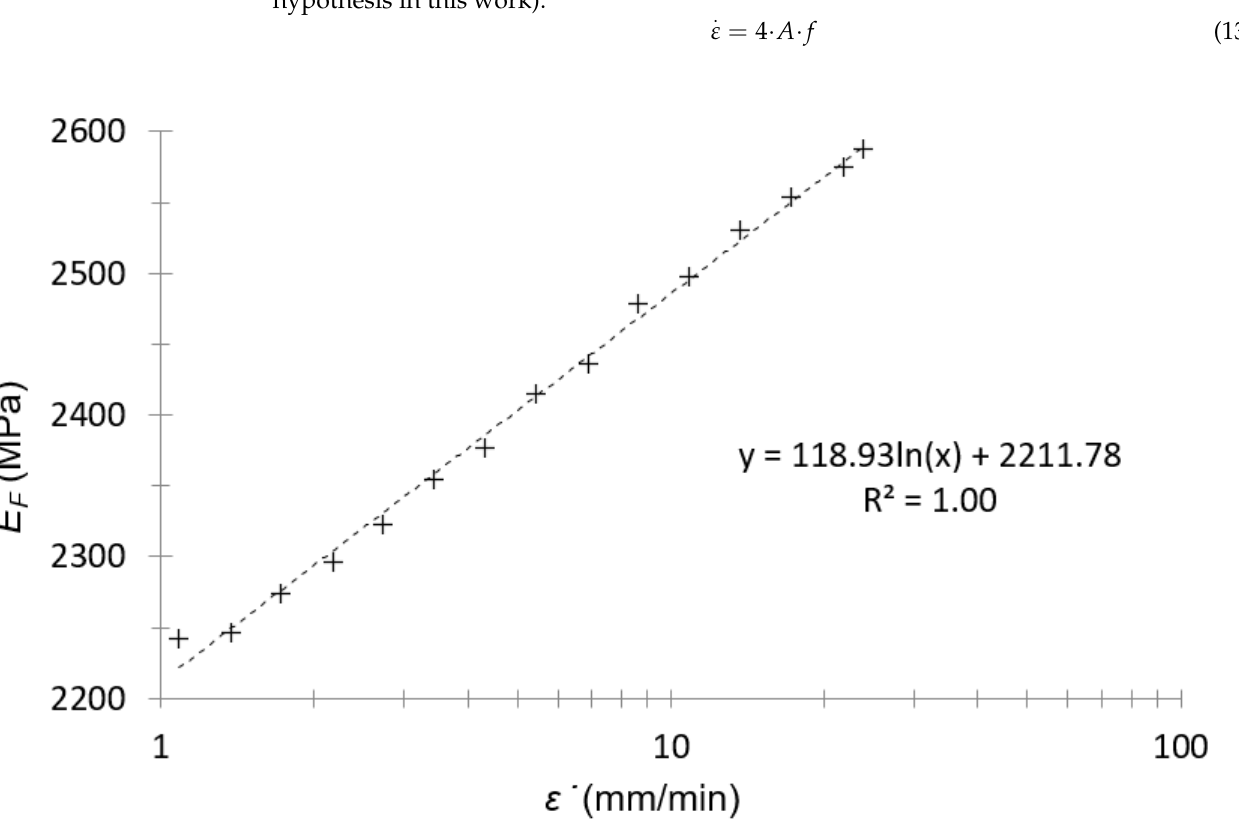
Figure 2. Storage modulus – amplitude plot for PA66.